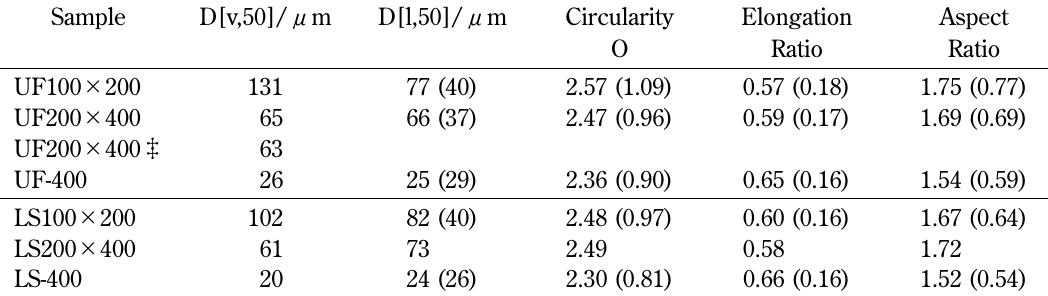
Table 2 . Size and Shape Parameters for UF and LS Vitrinite Size